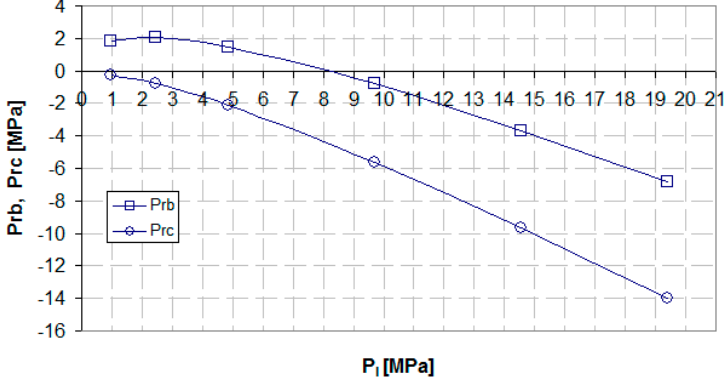
Figure 22. The variability in P rb and P rc as a function of the pressure P L for the coal from the North-East of Fairway San Juan basin.